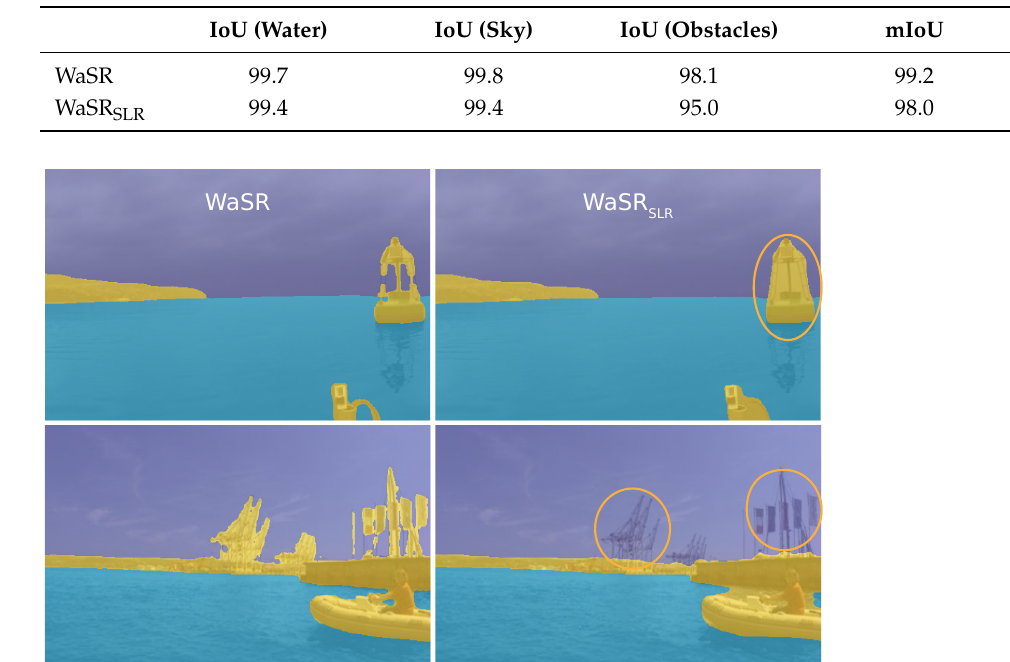
Figure 4. Segmentation obtained by WaSR trained with segmentation ground truth ( left ) and SLR ( right ). SLR sacrifices segmentation accuracy in regions irrelevant for obstacle detection performance (denoted with yellow